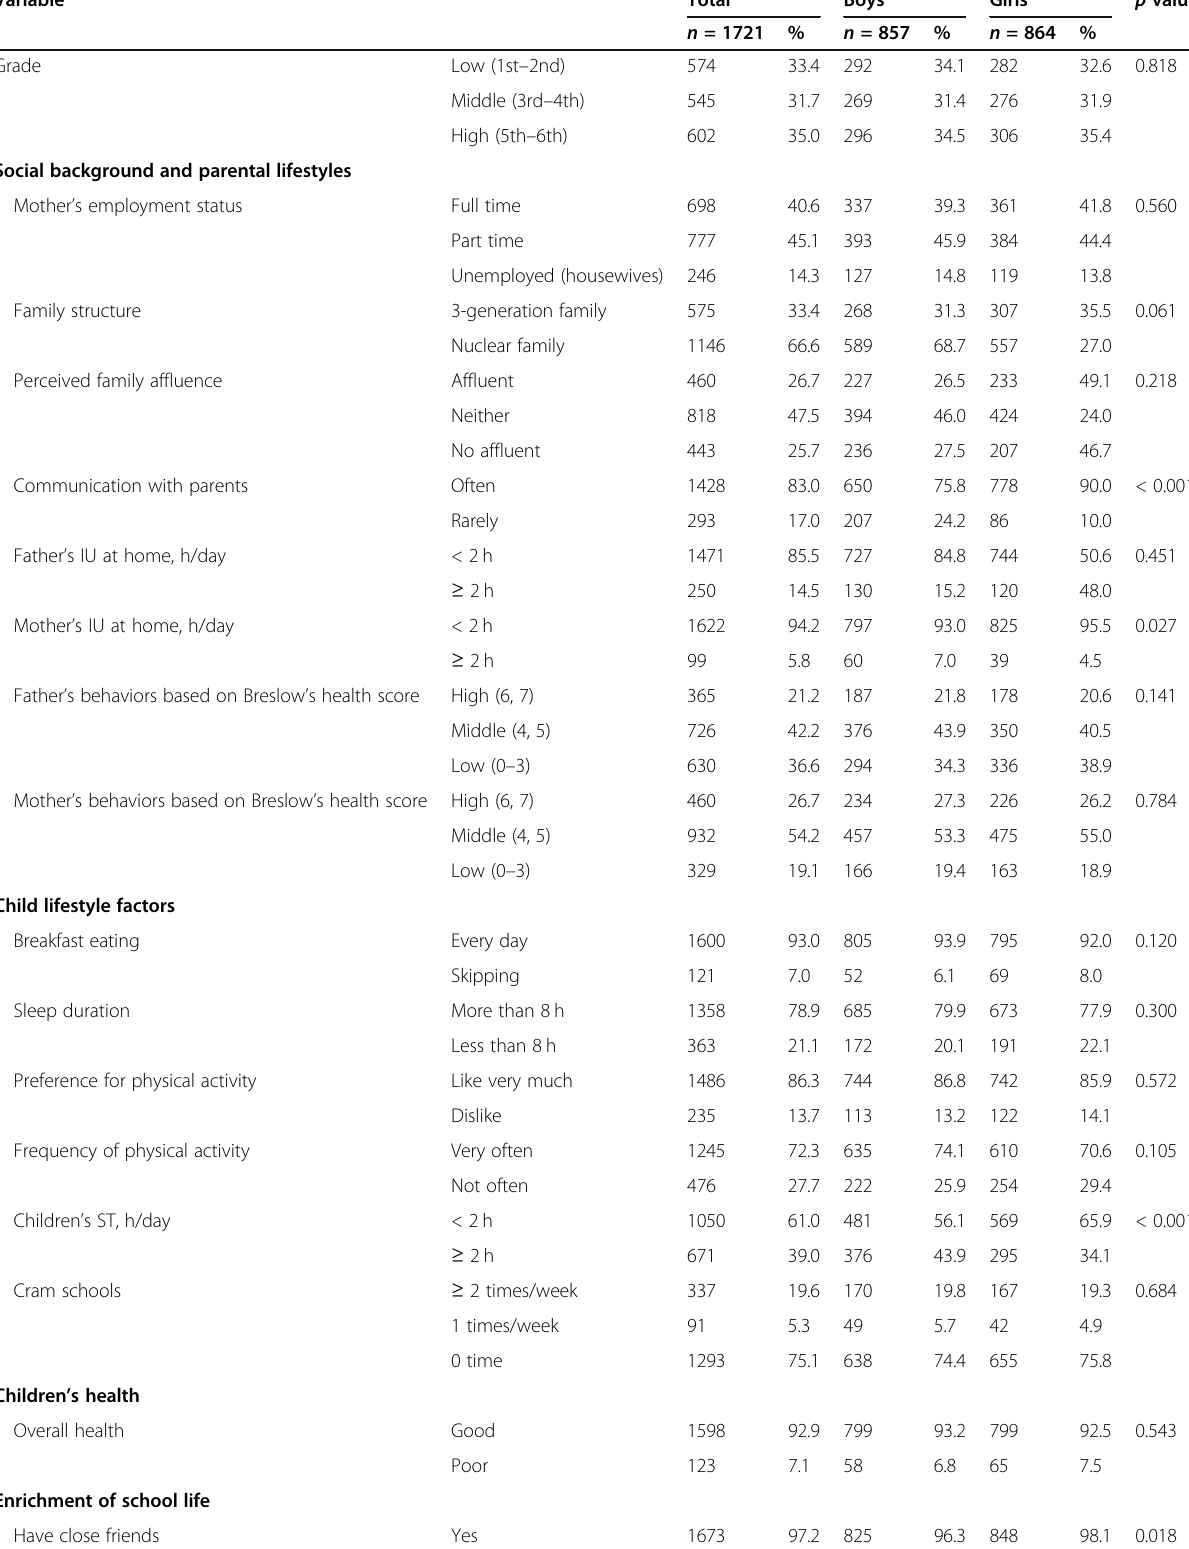
Table 1 Participant characteristics by gender ( n = 1721)